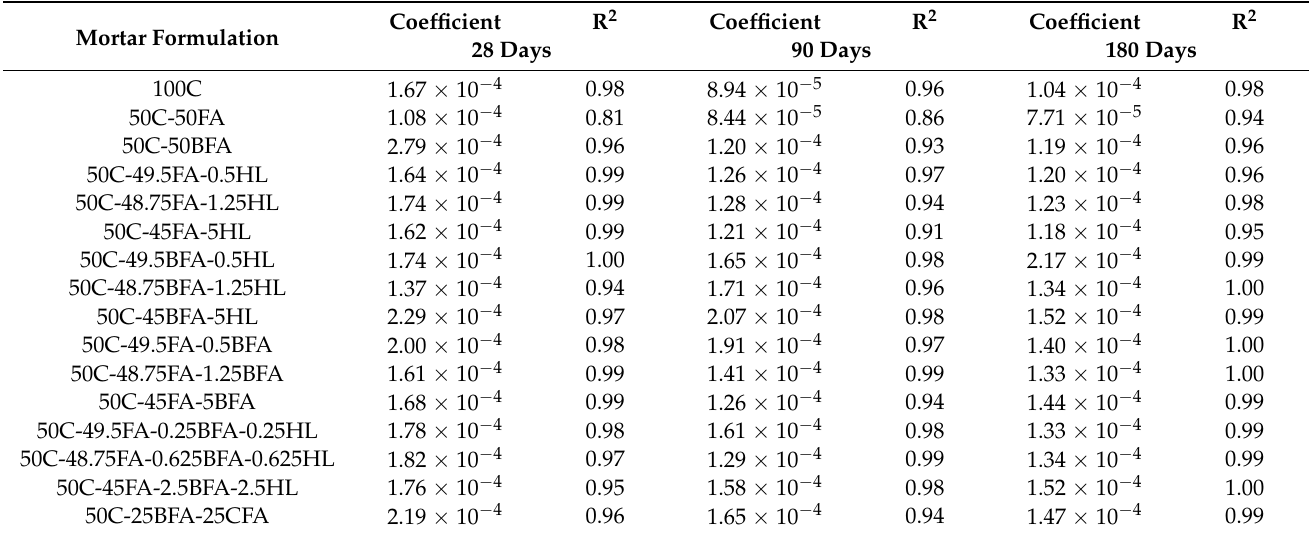
Table 5. Coefficient of water absorption by capillarity of